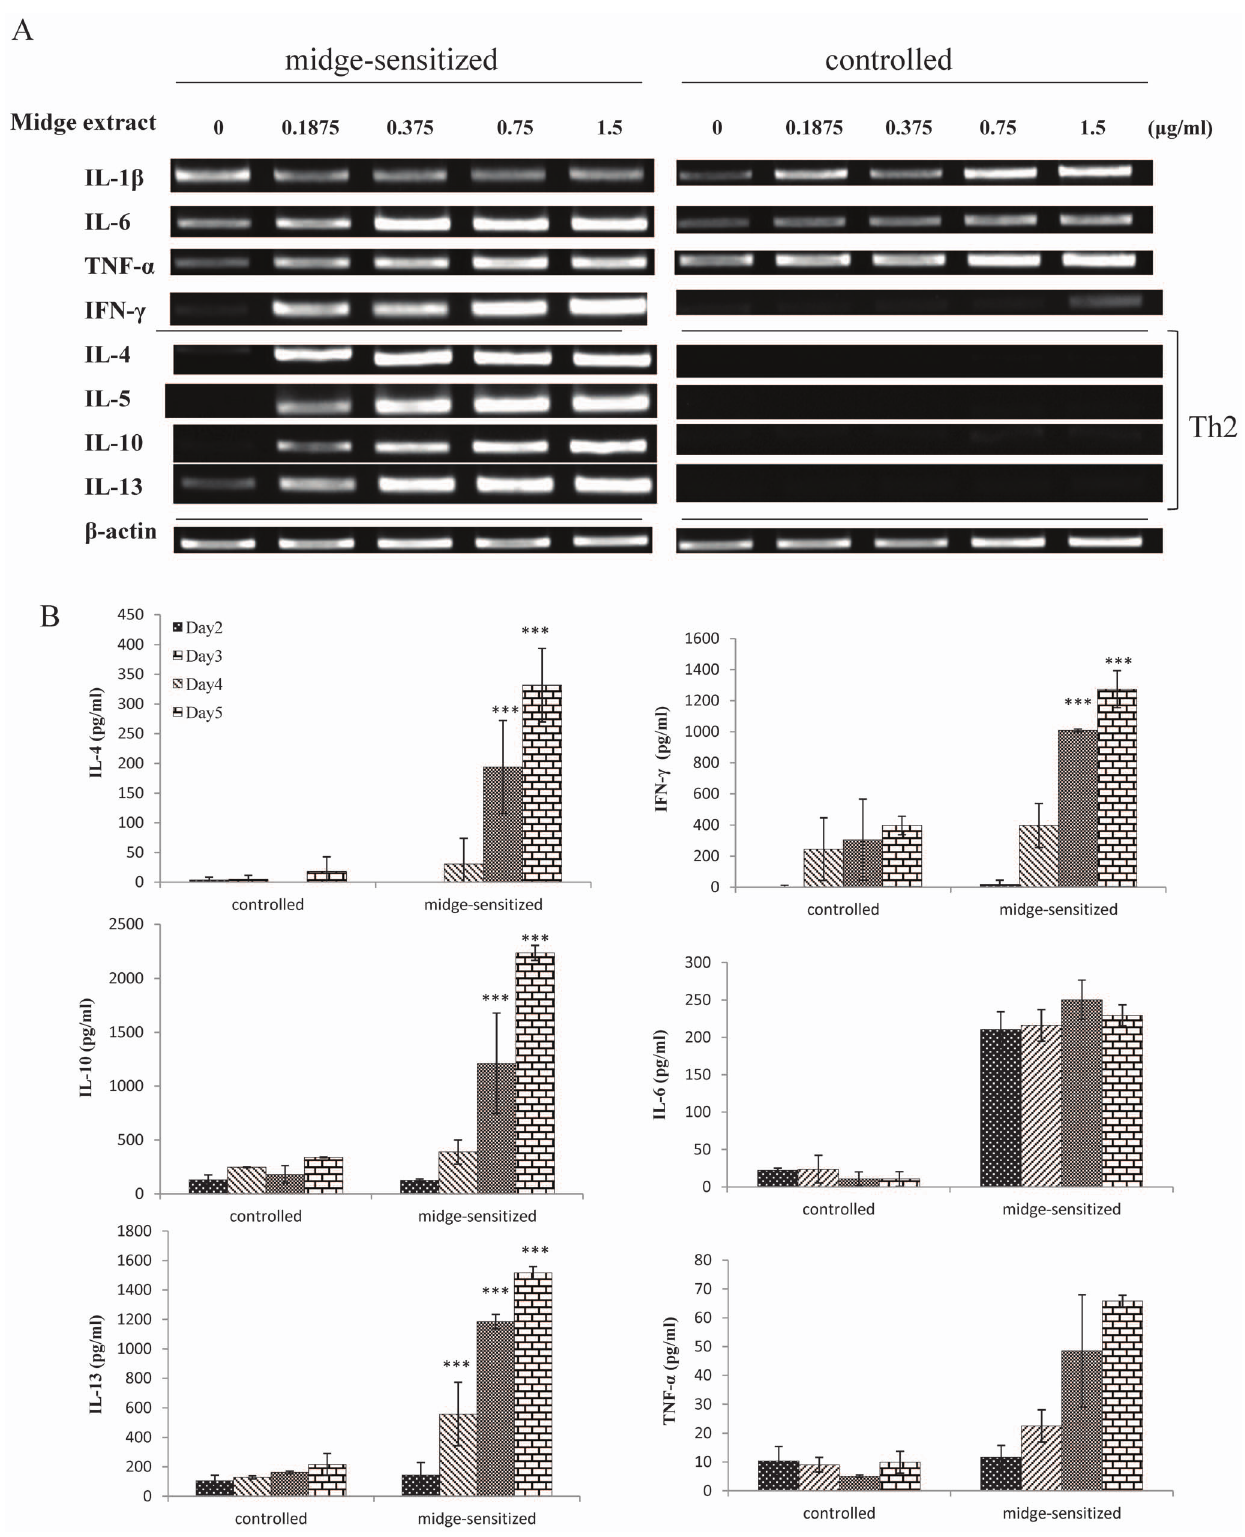
Figure 8. Cytokine expression levels of splenocytes from midge-sensitized or controlled mice. (A) Dose-dependent responses of midge extract on cytokine transcripts of splenocytes by RT-PCR. (B) Cytokine protein levels of splenocytes stimulated with 1.5 m g/ml of midge extract for 2–5 days. Cytokine data are expressed as means 6 SEM (n=5 per group). * p , 0.05; *** p , 0.001, by one-way ANOVA with the Dunnett t test.